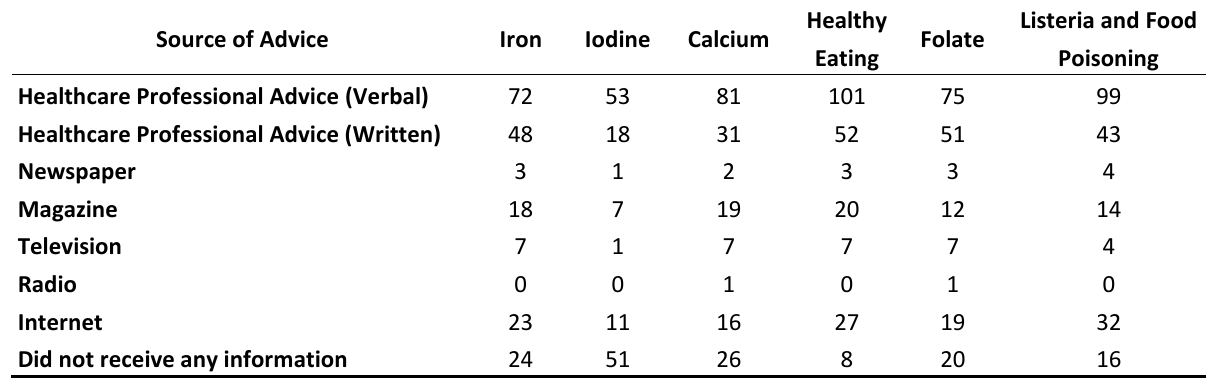
Healthy Listeria and Folate Eating